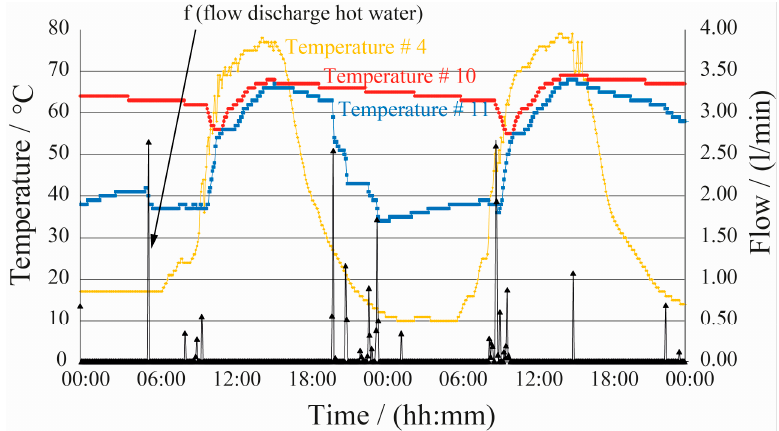
Figure 8. Measured temperatures and flow of the retrofitted solar domestic hot water system on 7 and 8 September, illustrating representative summer behaviour.